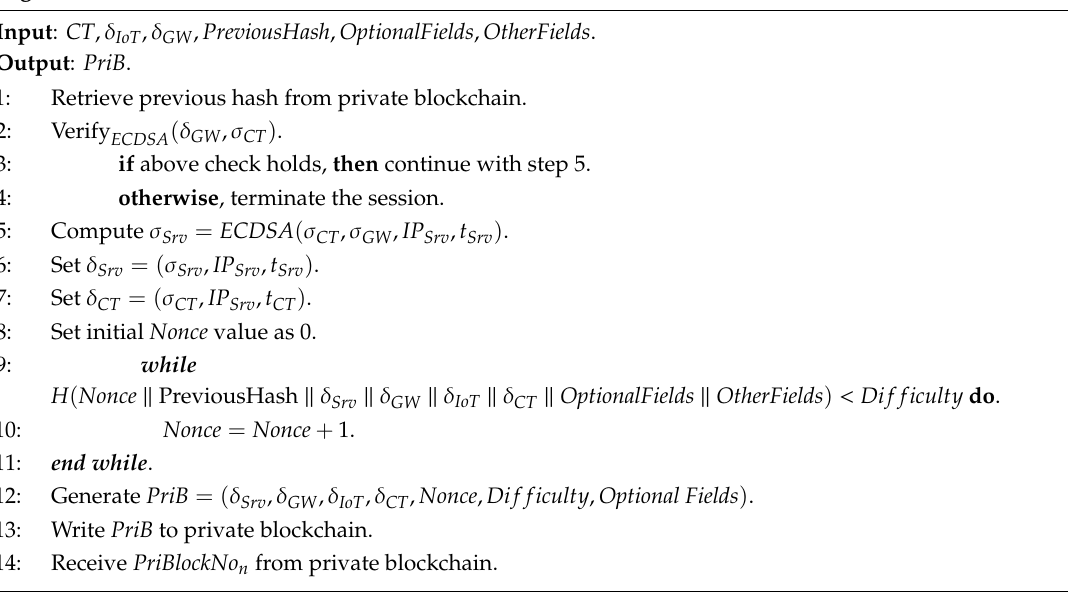
Algorithm 10: Private block